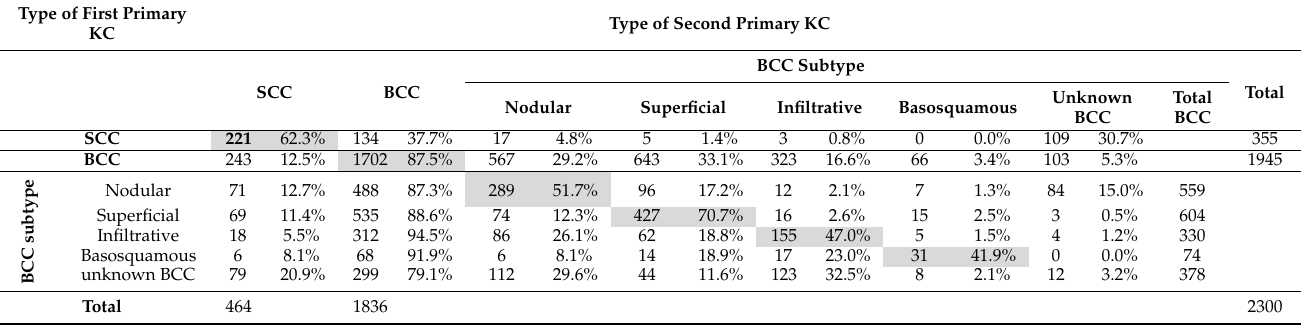
Table 4. Type of non-melanoma skin